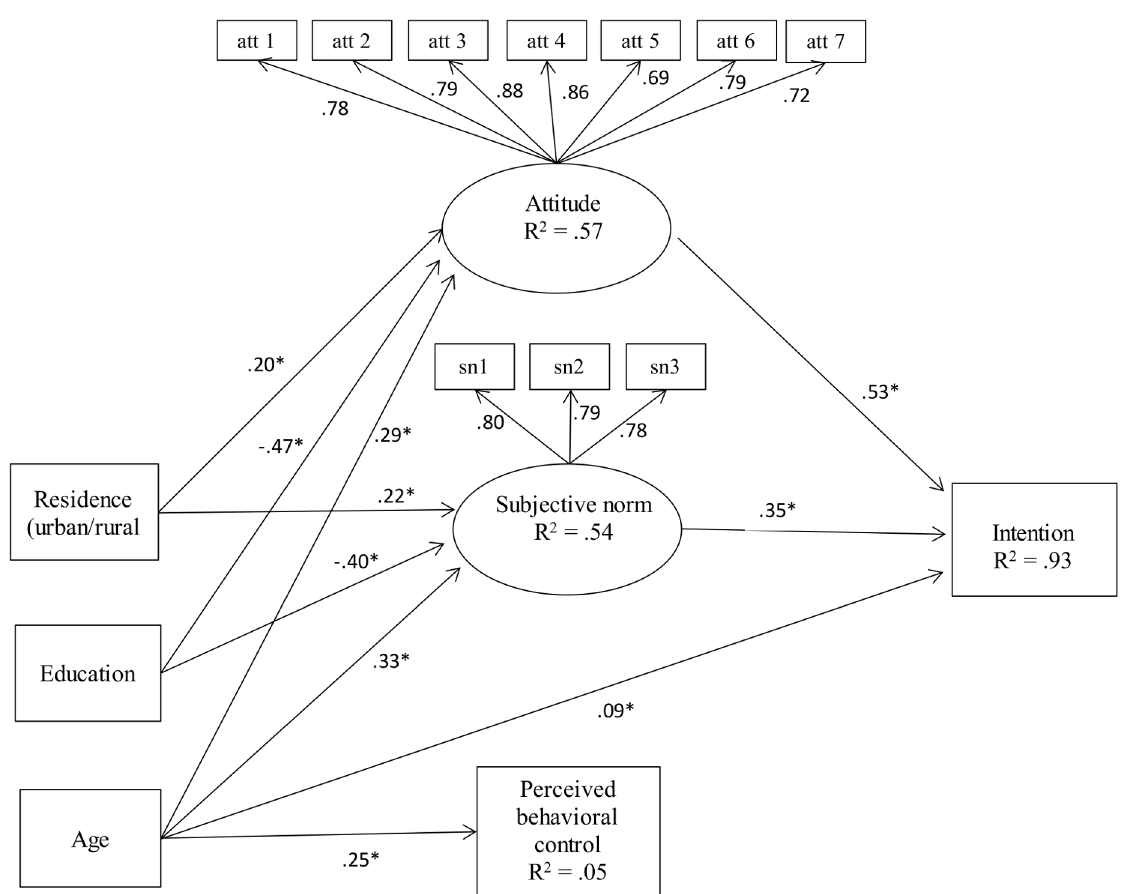
Fig 1. Structural model for the determinants predicting mothers ’ intentions to allow their daughters to undergo